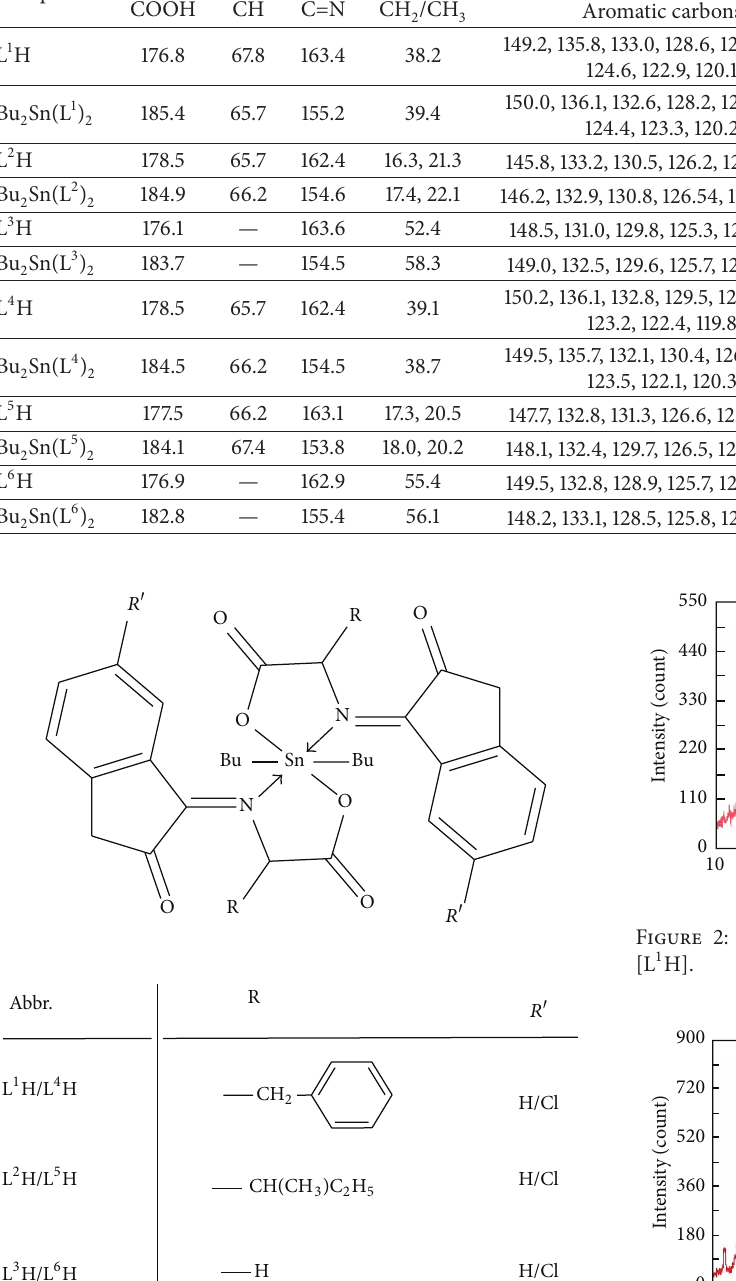
Table 4: 13 C NMR spectral data of the ligands and their corresponding organotin(IV) complexes. Chemical shift in ( 𝛿 ppm) Compounds